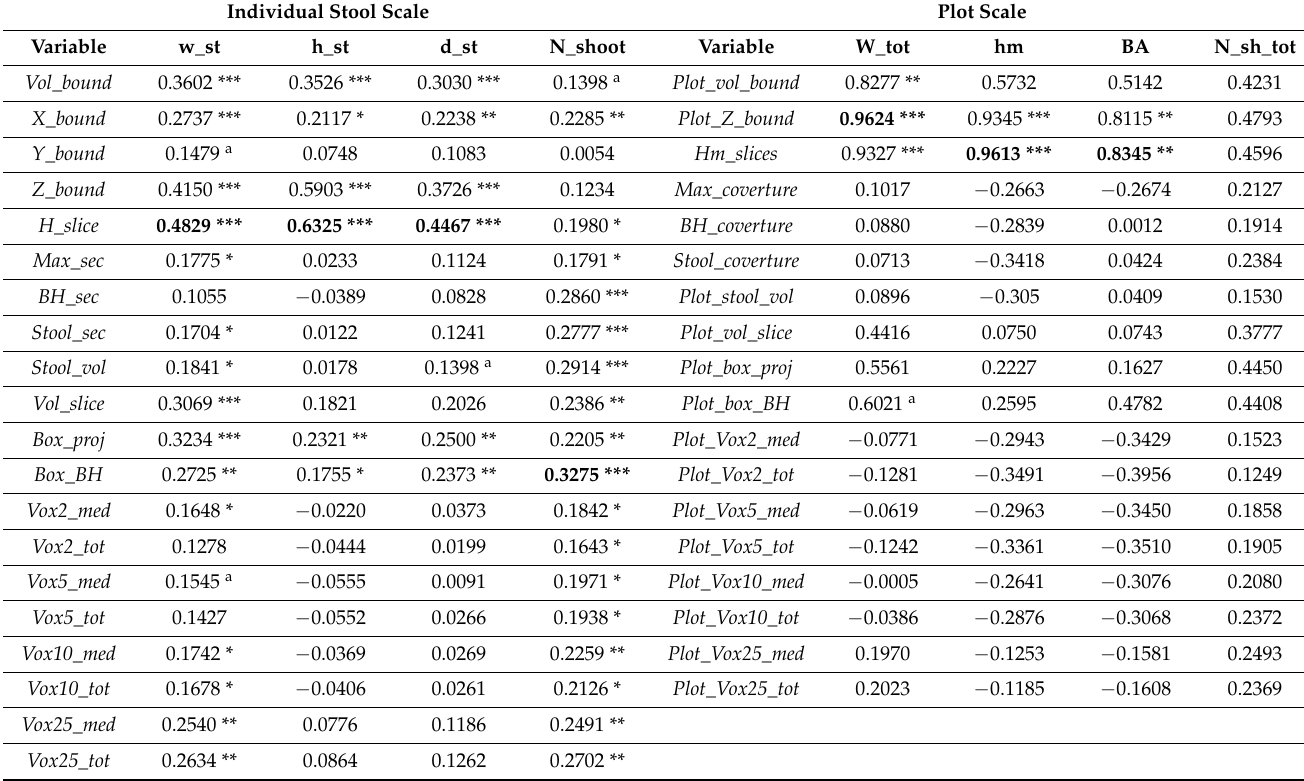
Table 4. Correlation analysis between the main dendrometric attributes and TLS-derived